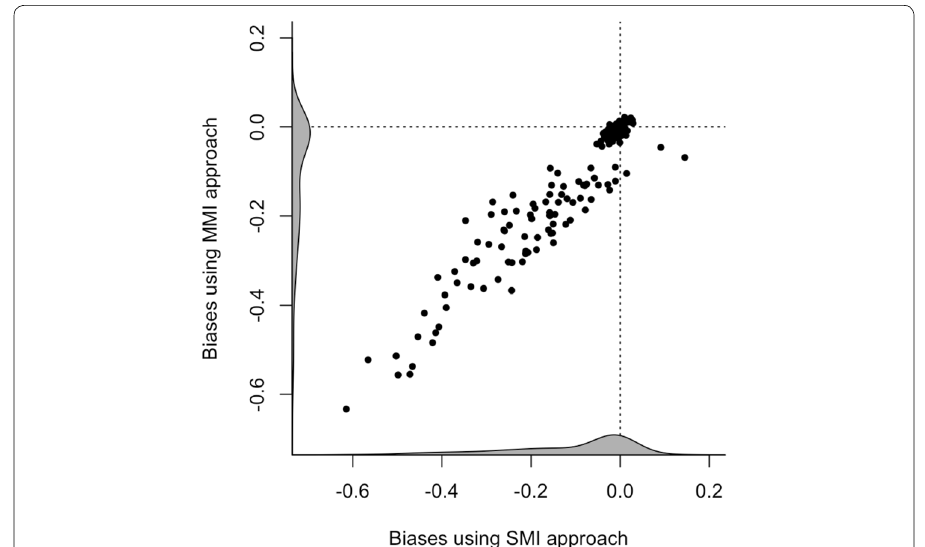
Fig. 2 Two-form design: correlation bias among the rotation variables